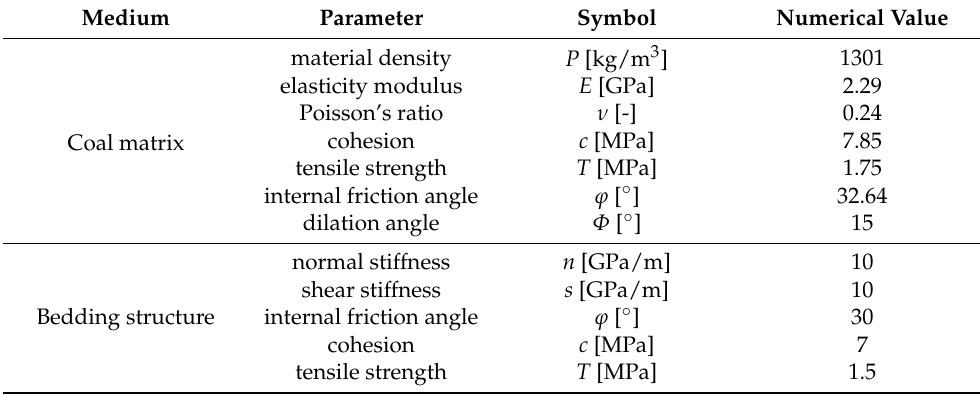
Table 3. Parameters of coal specimens involved in numerical